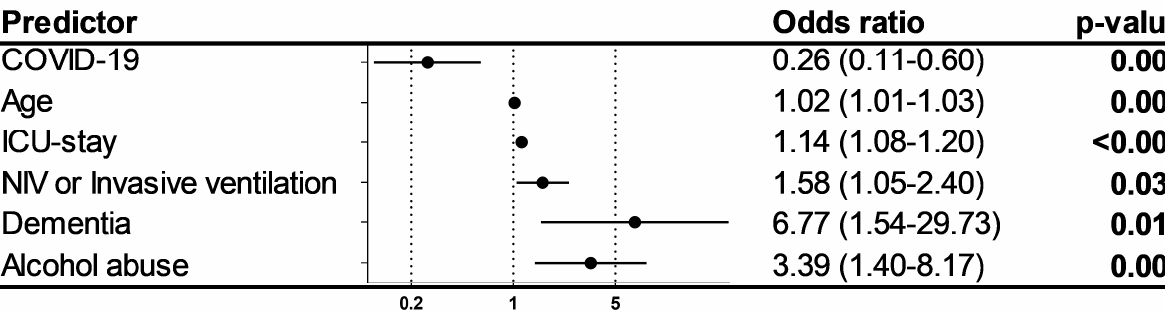
Figure 3. Fraction of delirium positive patients in different subgroups. Graph shows the fraction of patients with delirium as diagnosed by Nudesc in COVID-19 and non-COVID-19 patients in different subgroups. NIV: non-invasive ventilation; IV: Invasive ventilation.